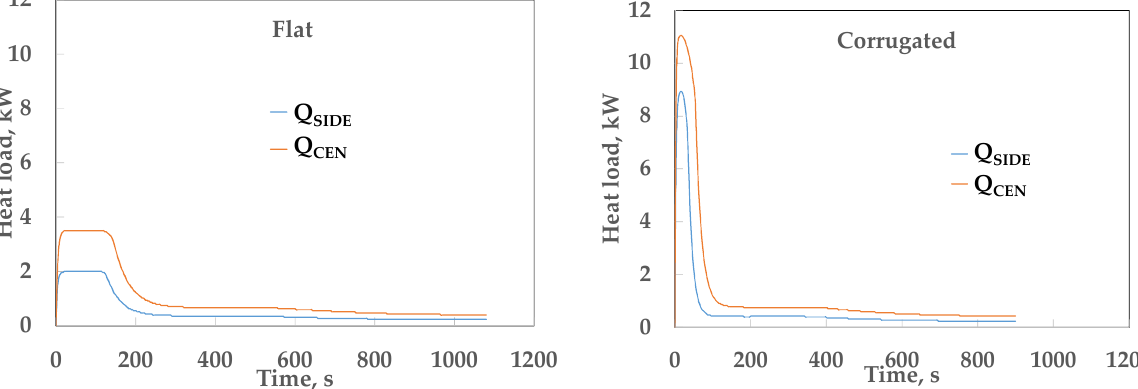
Figure 9. Heat load for the flat and corrugated LHST.